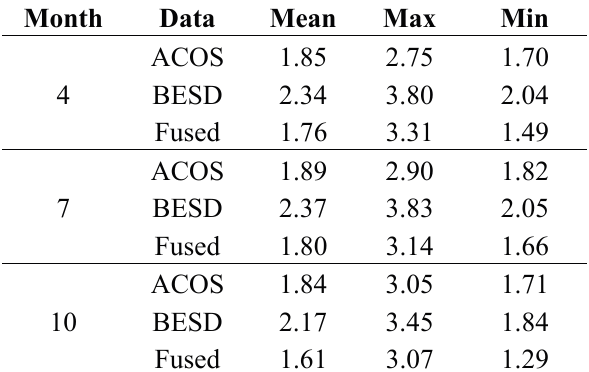
Table 2. Basic global standard deviation statistics for interpolated XCO July, and October 2010. Unit: